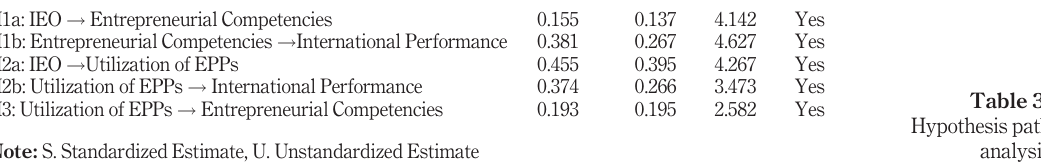
Table 2. Goodness of statistics of the structural model